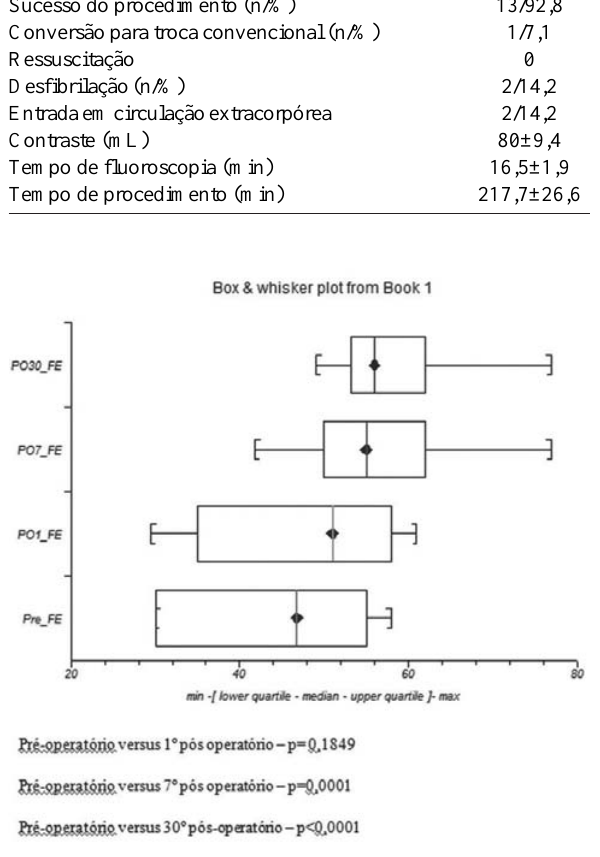
Fig. 6 - Fração de ejeção do ventrículo esquerdo no pré-operatório, 1º pós-operatório, 7º pós-operatório e 30º pós-operatório